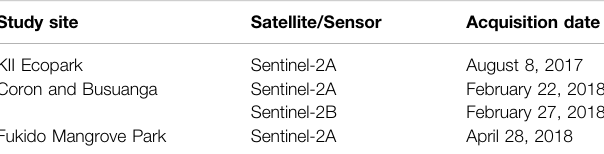
TABLE 2 | Downloaded Sentinel-2 images used for the initial extent and zonation mapping of